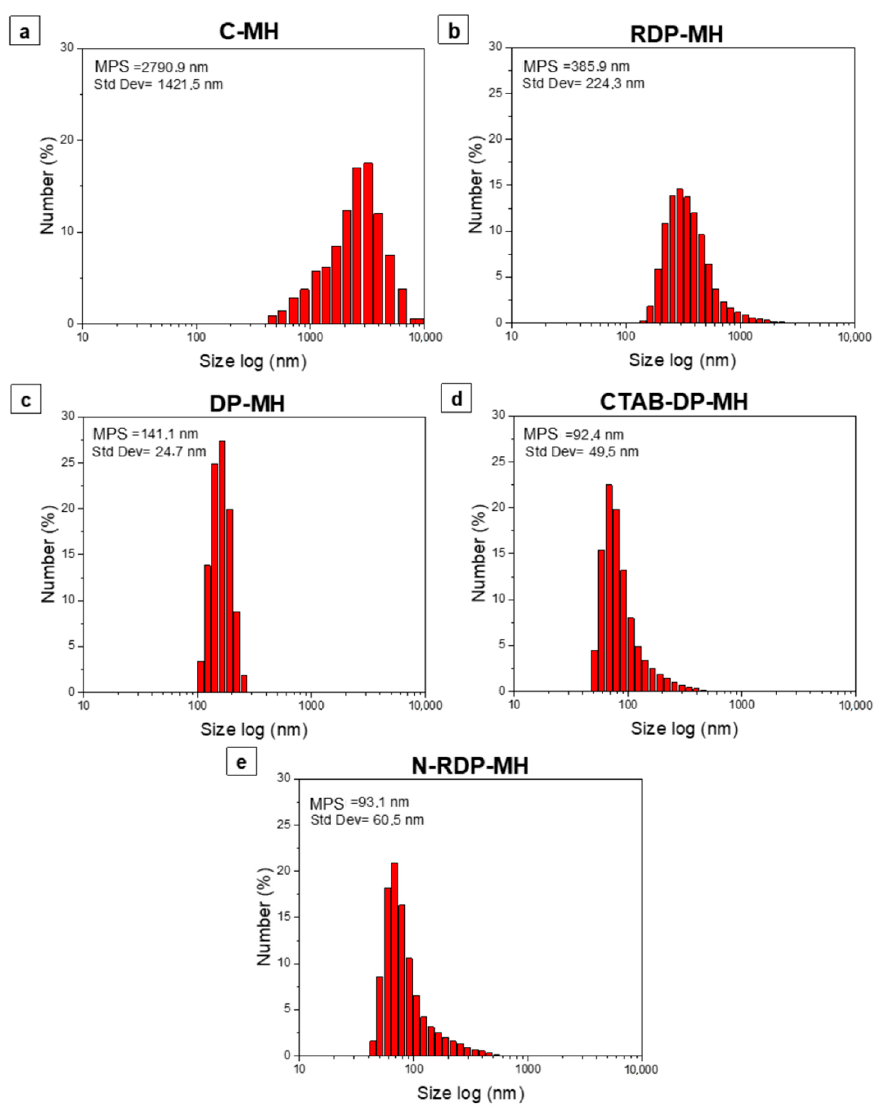
Figure 4. Dynamic light scattering (DLS) size distribution by number (%) of ( a ) C-MH, ( b ) RDP-MH, ( c ) DP-MH, ( d ) CTAB-DP-MH, ( e ) N-DP-MH.